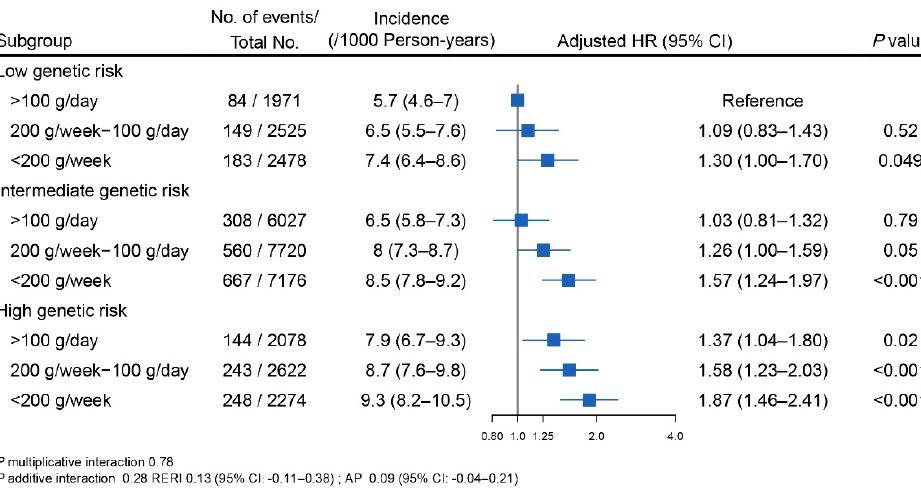
Figure 1. The joint association of genetic risk and fruit intake with incident stroke. Age- and sex-adjusted incidence rates per 1000 person-years of stroke were calculated using the Poisson regression. The overall genetic risk for stroke was defined as high (quintile 5 of PRS), intermediate (quintile 2–4 of PRS), and low (quintile 1 of PRS). In these comparisons, the participants with a low genetic risk and a fruit intake > 100 g/day served as the reference group. HRs were derived from the Cox proportional hazards models stratified by cohort and adjusted for age (continuous), sex (male, female), region (North/South China), urbanization (urban, rural), education level (less than high school, high school, or above), current smoking status (yes, no), alcohol drinking status (yes, no), physical activity (continuous), body mass index (continuous), diet score (continuous), and vegetables intake (daily intake ≥ 500 g/day or not). Multiplicative interaction was evaluated using the hazard ratios for the product term between the fruit intake (< 200 g/week vs > 100 g/day) and the PRS (low vs high). p multiplicative interaction was 0.78. To estimate the additive interaction, the participants with a fruit intake of ≥ 200 g/week and the low genetic risk (quintile 1 of PRS) were used as the reference with consideration of the practical interpretations. Two indexes were calculated: the relative excess risk due to the interaction (RERI) and the attributable proportion due to the interaction (AP). p additive interaction was 0.28. RERI was 0.13 (95% CI: − 0.11–0.38). AP was 0.09 (95% CI: − 0.04–0.21). Abbreviations: CI, confidence interval; HR, hazard ratio; PRS, polygenic risk score.